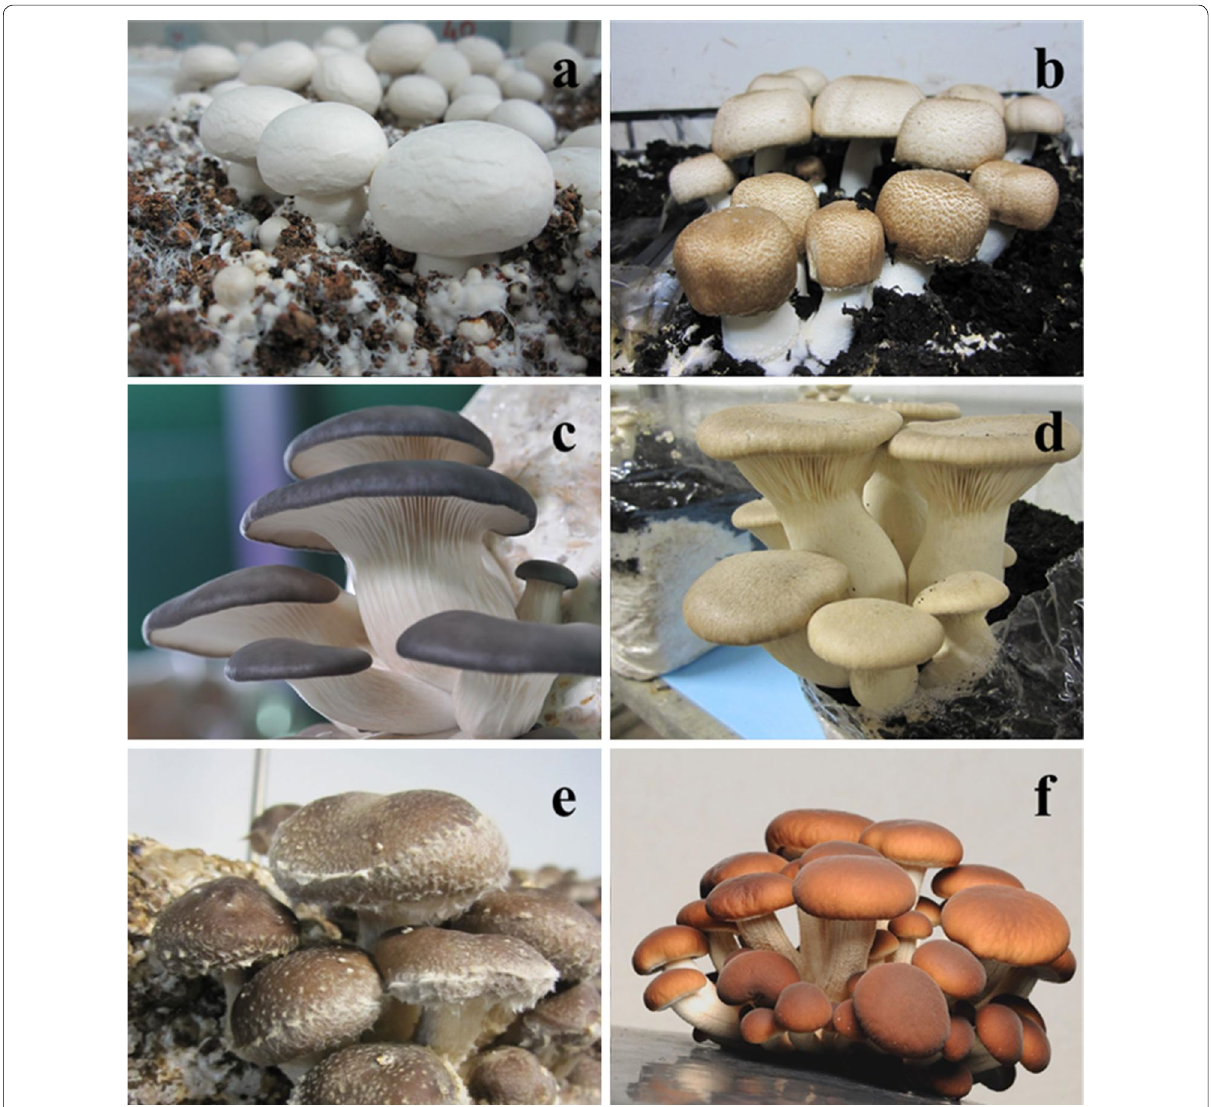
Fig. 2 Production of mushrooms on supplemented substrates. a Agaricus bisporus ; b Agaricus subrufescens ; c Pleurotus ostreatus ; d Pleurotus eryngii